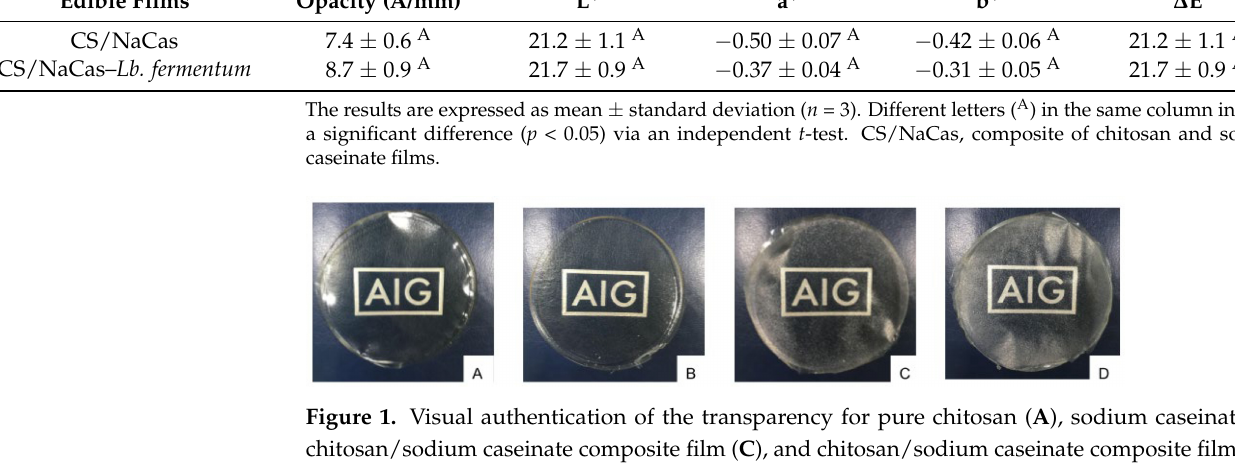
Table 5. Opacity and color parameters of the composite edible film with or without Lb. fermentum . Edible Films